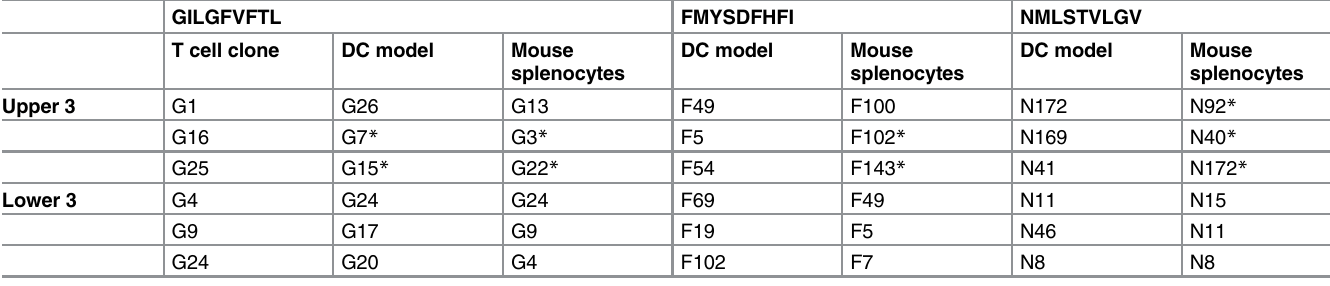
Table 2. Summary of pre-selection